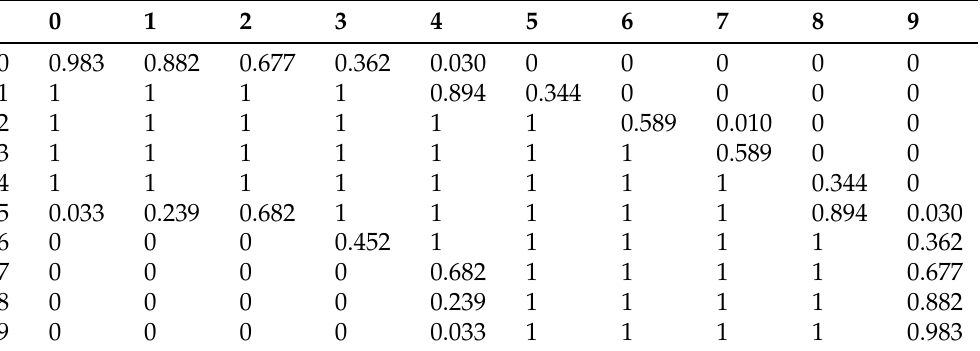
Table 1. Cell fullness function for grid 21 × 11